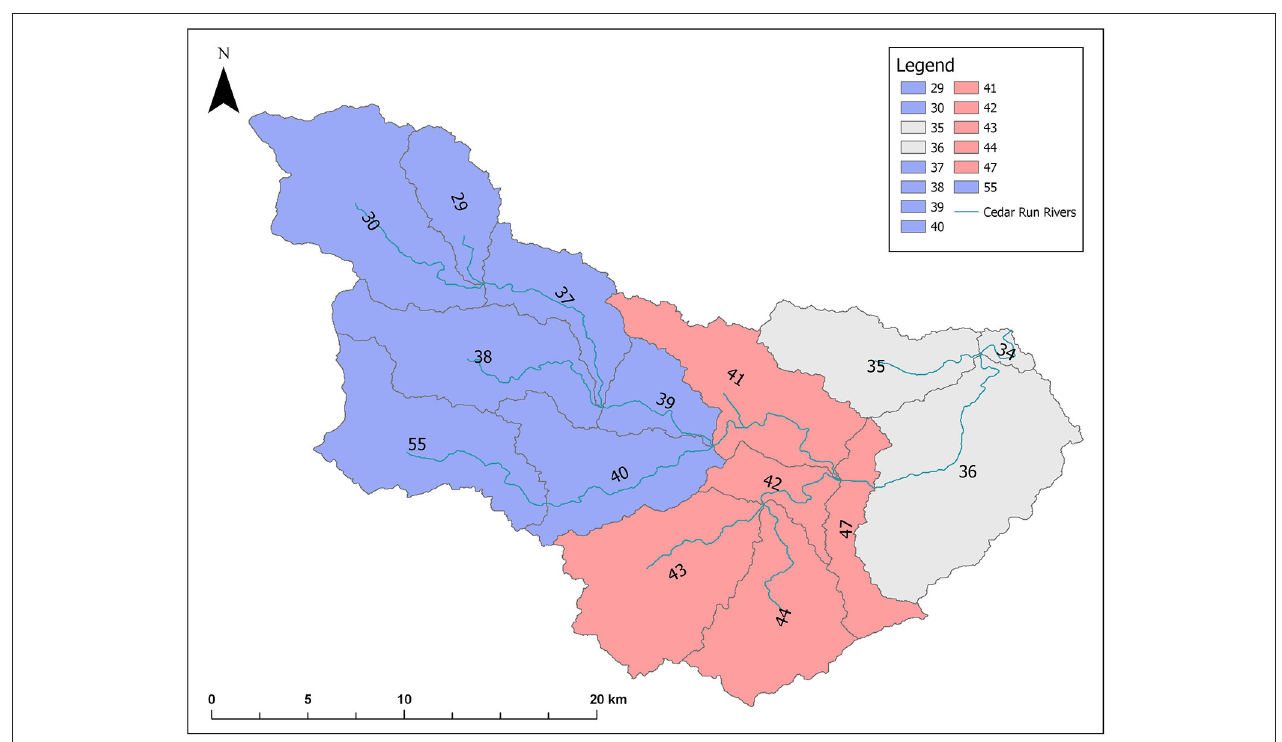
FIGURE 4 | Cedar Run Watershed with Upstream (blue) defined as segments 29, 30, 37, 38, 39, 40, 55 and Downstream (red) defined as segments 41, 42, 43, 44, 47.